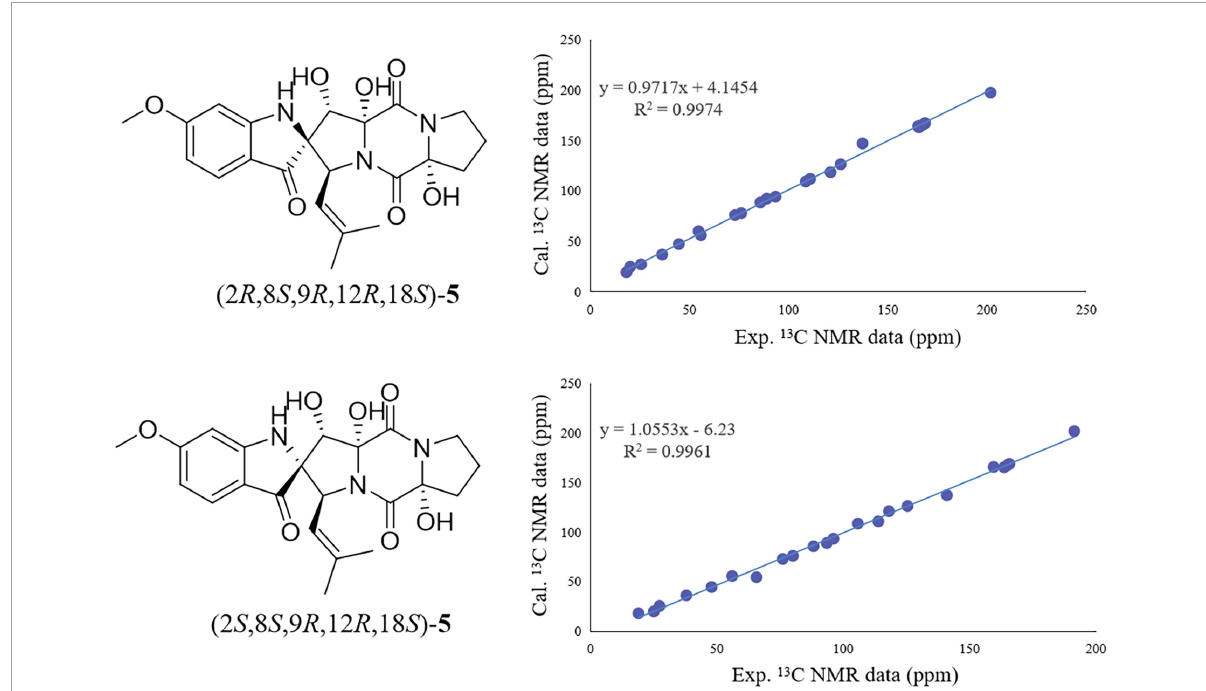
FIGURE6 Regression analysis of experimental vs. calculated 13 C NMR chemical shifts of 5 with 2 R , 8 S , 9 R , 12 R , 18 S and 2 R , 8 S , 9 R , 12 R , 18 S configurations at the mPW1PW91/6-31 + G(d,p) level.